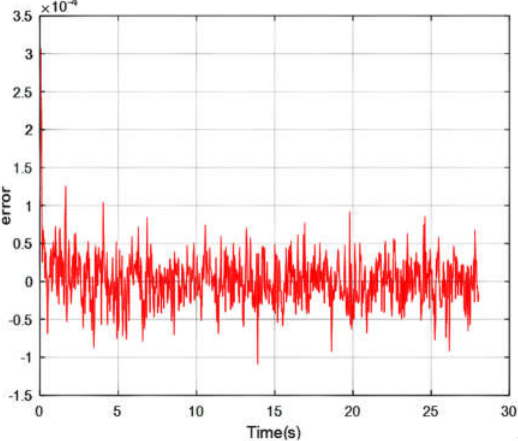
Figure 7. Error curve between test output and expected output of low-pressure spool speed under the elastic BP neural network.